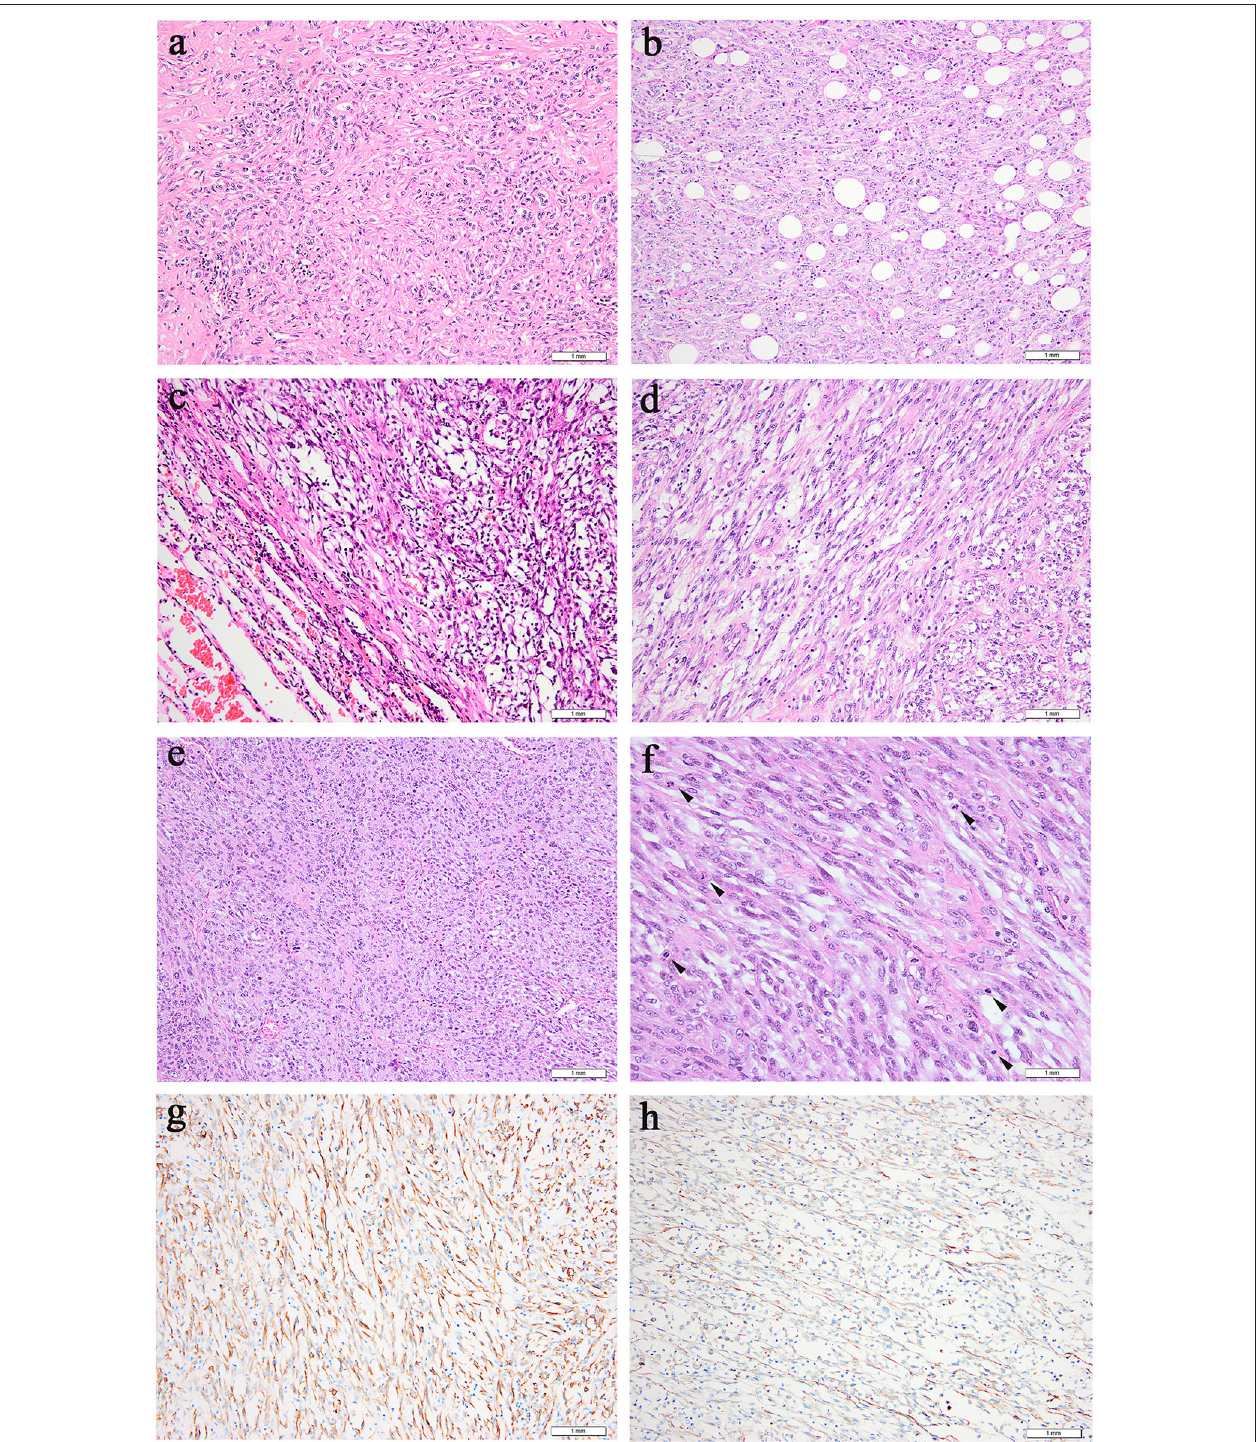
FIGURE 2 | Microscopic features (hematoxylin and eosin). (a,b) Case 1, (c–f) Case 2. (a) Prominent collagenous background was observed in the primary lung lesion. ( b) Metastatic neck lesion showed adipose infiltration. (c) A clear boundary between tumors and normal lung tissue in some areas could be observed in primary lung lesion. (d) Spindle tumor cells of thigh lesion arranged in fascicular. (e) Metastatic lesion of ilium exhibited densely arranged tumor cells. (f) More dense tumor cells arrangement, more obvious atypia, more vacuolated and prominent nucleoli, higher mitotic activity (an arrowhead is shown) were observed in metastatic lesion of ilium. (g) Positive cytoplasmic ALK staining was observed in all 5 specimens. ( h) Focally positive staining for smooth muscle actin was shown in Case 2.